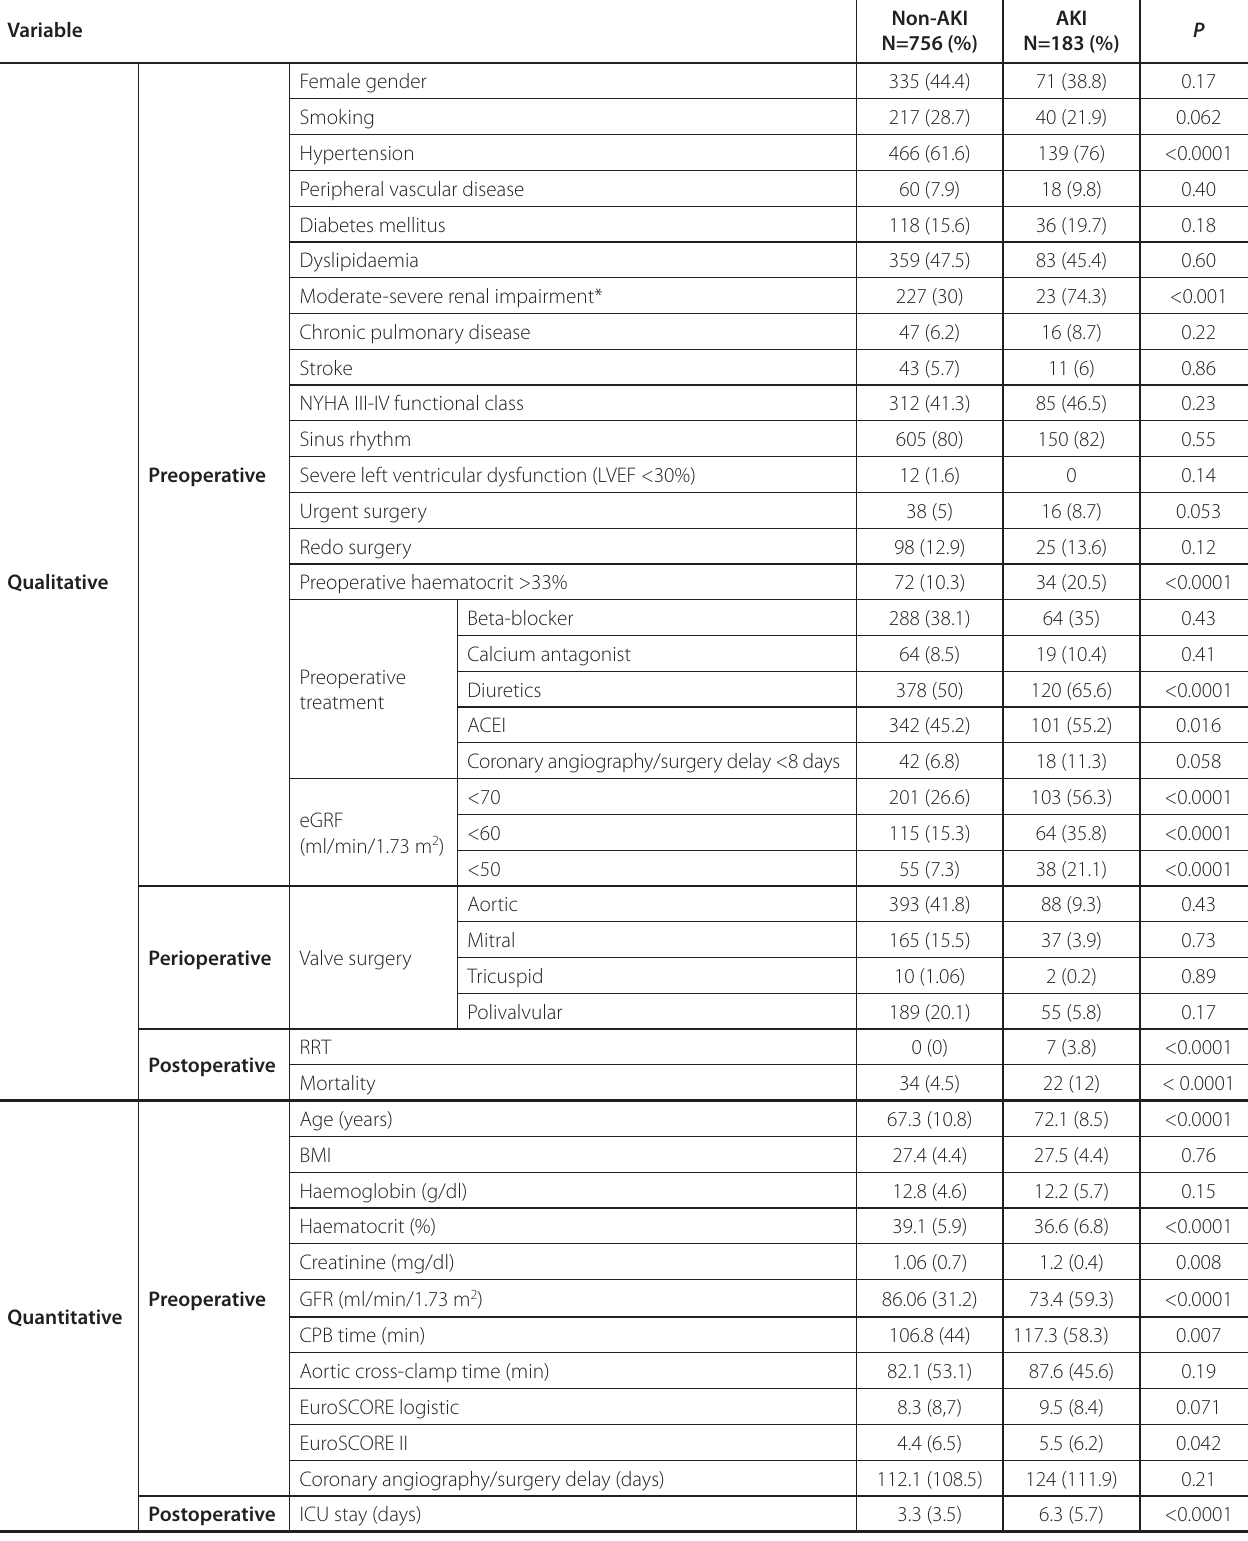
Table 2 . Risk factors in patients with and without AKI after heart valve surgery.